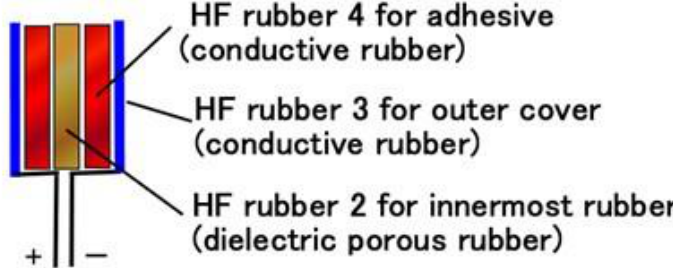
Figure 1. The structure of the primary component unit of HF-rubber mechanoreceptors.